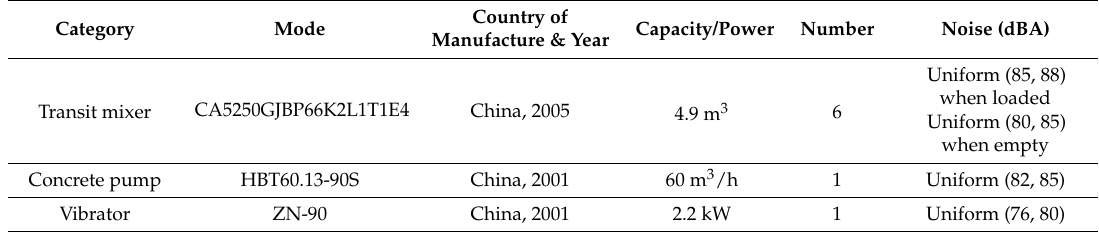
Table 1. Properties and source noise levels of various types of equipment for concerting.